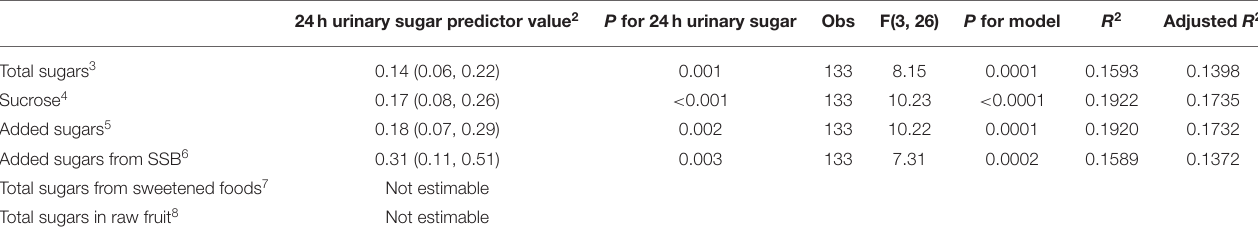
TABLE 4 | Associations between dietary sugars intakes (g/d) and estimated 24h urinary sucrose + fructose excretion from a multivariate log linear regression model 1 . 24h urinary sugar predictor value 2 P for 24h urinary sugar Obs F(3, 26) P for